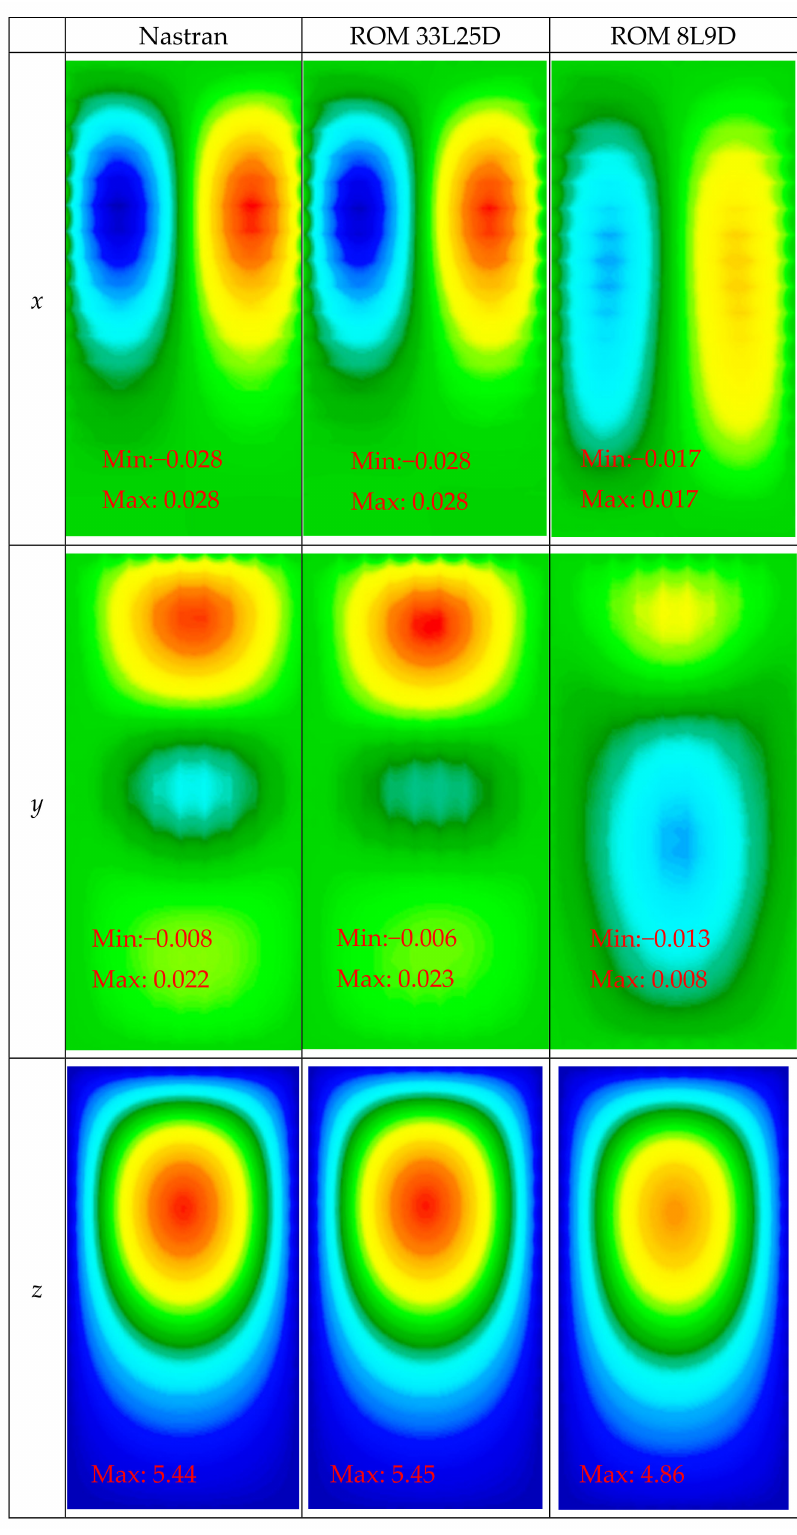
Figure 16. Displacement fields along x , y , and z of the skin predicted by Nastran and the 33L25D and 8L9D ROMs in units of thickness. Fore-aft asymmetric pressure of magnitude +20